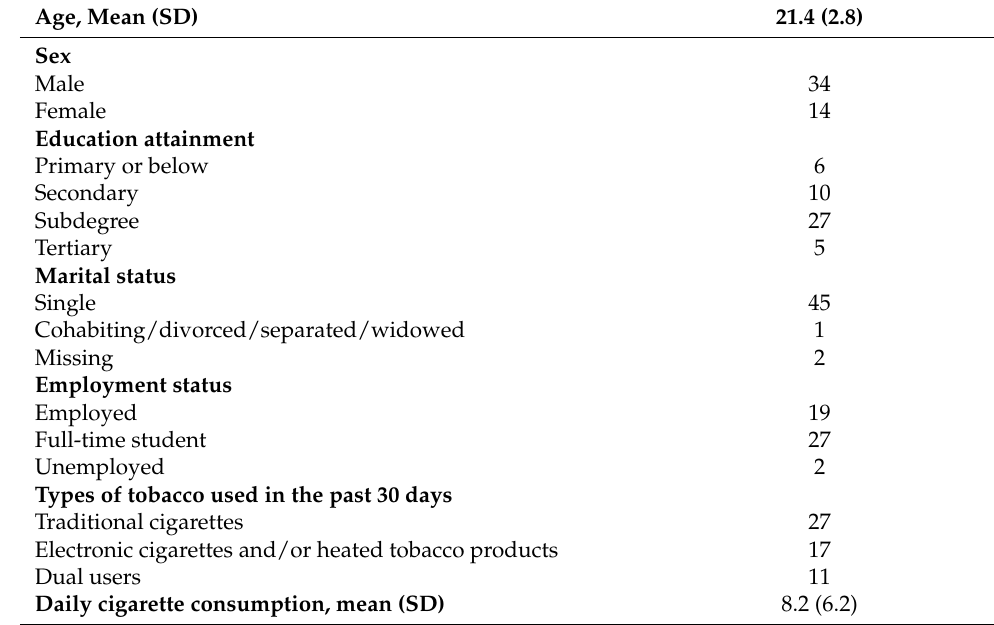
Table 1. Demographic characteristics and smoking profile of the participants (N =